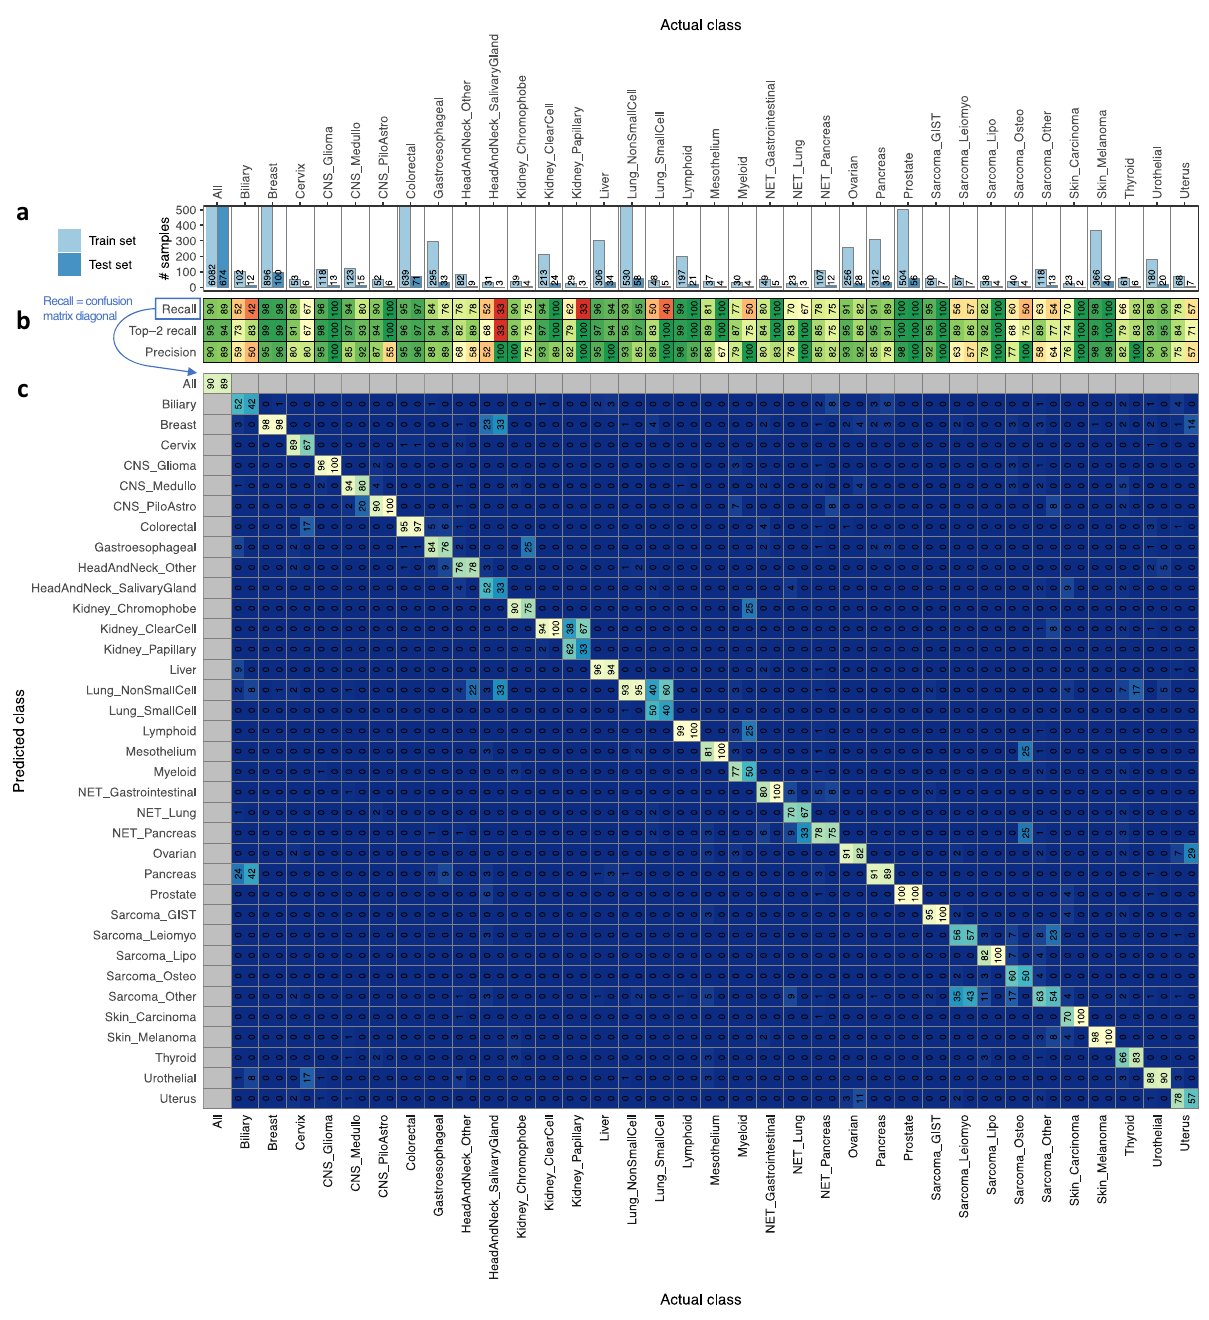
Fig. 2 Performance of CUPLR. a The total number of samples for each cancer type for the training set (left columns) and held out test set (right columns). Note that the y axis of a is truncated to better visualize cancer types with small sample sizes. b , c also have the same left/right column layout corresponding to the training set cross-validation and test set performance. b Summary of performance metrics. Recall: % of correctly classi fi ed samples per cancer type, and is equivalent to the diagonal values in c . Top-2 recall: % of correctly classi fi ed samples when considering the 2 highest probability cancer types as correct. Precision: % of correctly classi fi ed samples amongst samples predicted as a particular cancer type. Overall performance metrics (i.e. under the ‘ All ’ column) are micro-averages. c Confusion matrix showing the performance of CUPLR where columns represent the % of samples in a cancer type cohort predicted as a particular cancer type. The diagonal represents the % of samples correctly predicted as a particular cancer type (equivalent to recall). Raw data for performance metrics and confusion matrix in b , c can be found in Supplementary data 4. Cancer type abbreviations: CNS central nervous system, CNS_Medullo medulloblastoma, CNS_PiloAstro pilocytic astrocytoma, NET neuroendocrine tumor, Sarcoma_GIST gastrointestinal stromal tumor, Sarcoma_Leiomyo leiomyosarcoma, Sarcoma_Lipo liposarcoma, Sarcoma_Osteo osteosarcoma, Sarcoma_Other sarcomas other than leiomyosarcoma, liposarcoma or gastrointestinal stromal